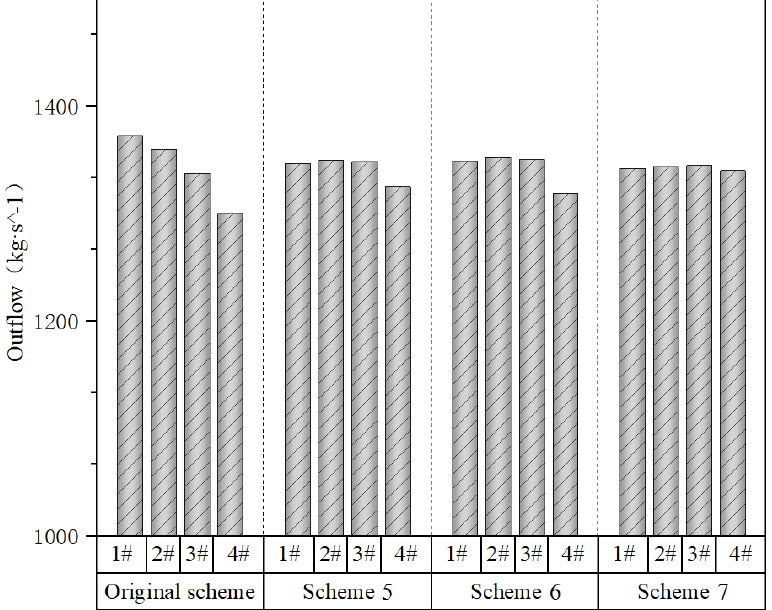
Figure 21. Outflow discharge of each